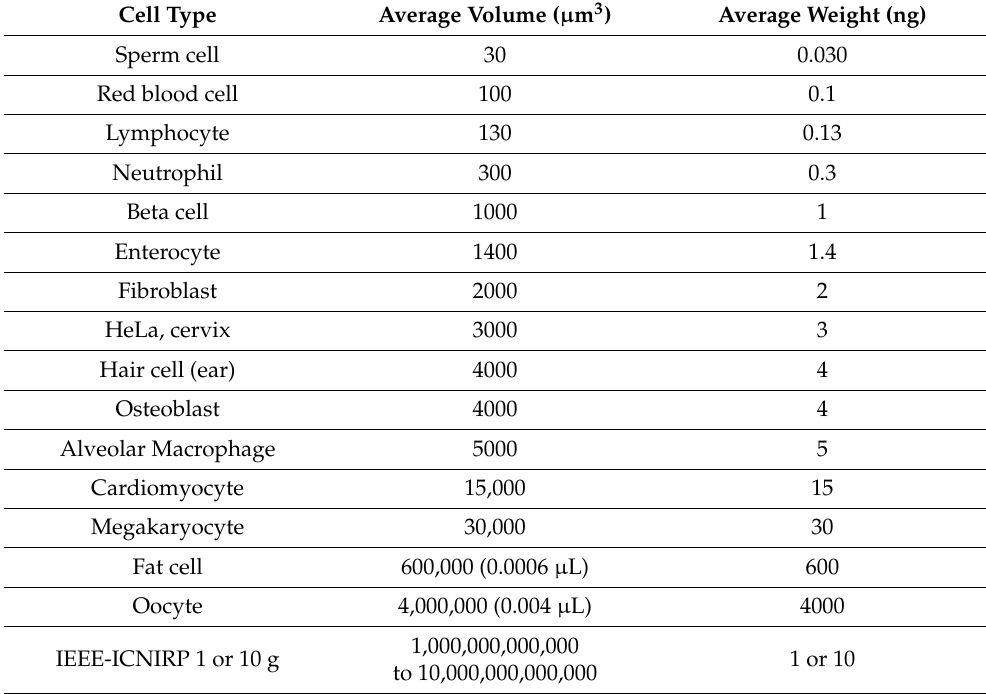
Table 4. Cell sizes in humans compared to IEEE-ICNIRP